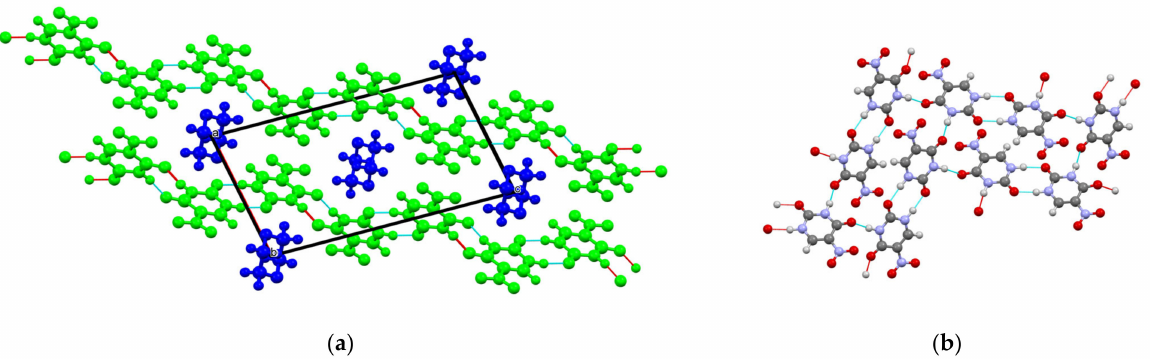
Figure 11. ( a ) Projection, along b, of the crystal packing in (X). ( b ) Detail of the 5NU H-bonded layer in (X) .